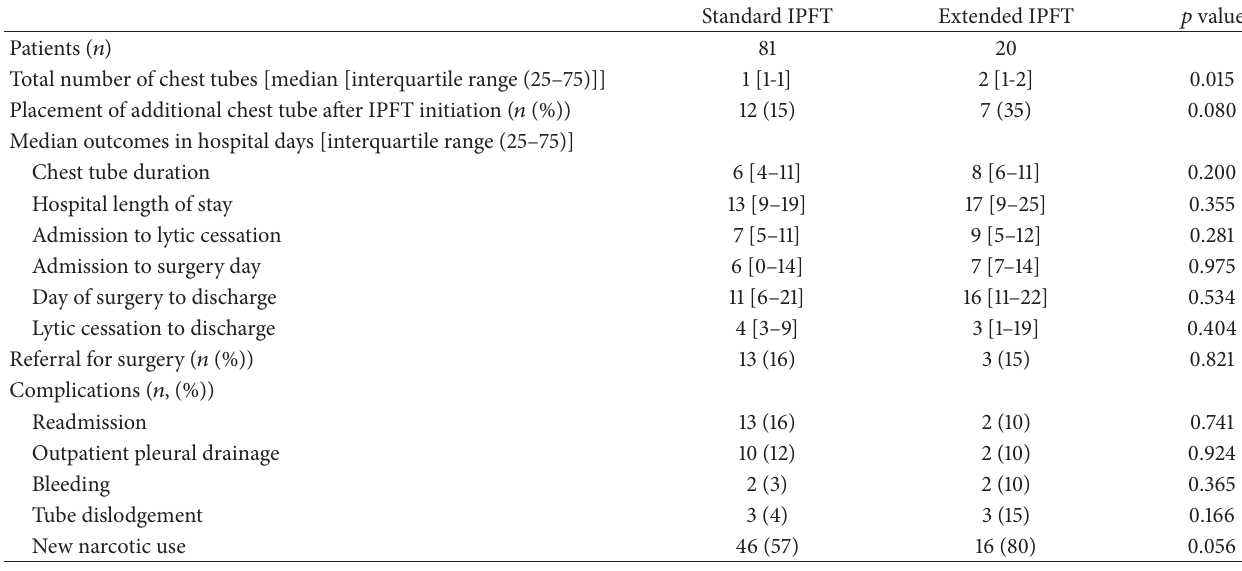
Table 2: Outcomes of patients receiving intrapleural